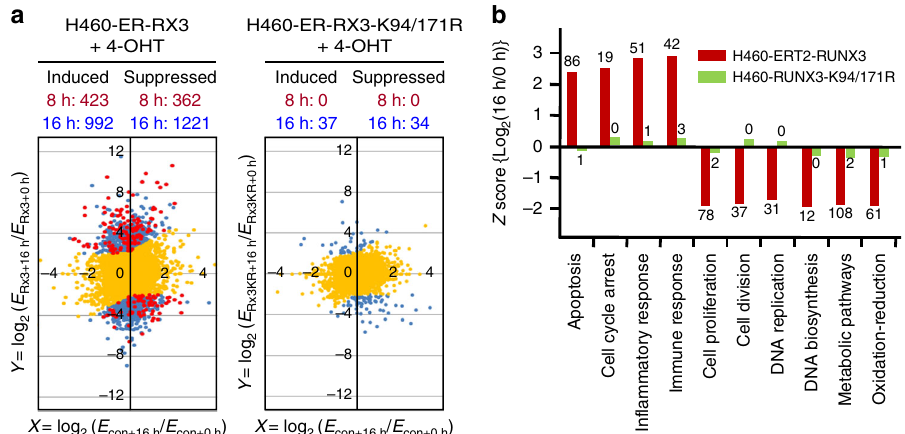
Fig. 10 The R-point governs multiple programs of tumor suppression. a H460-vec, H460-ERT2-RUNX3, and H460-ERT2-RUNX3-K94/171R cells were serum-starved for 24 h, and then stimulated with 10% serum or 10% serum + 1 μ M 4-OHT for 0, 8, or 16 h. RNA was extracted from the cells, and gene expression patterns were analyzed by mRNA sequencing. Expression of genes 8 or 16 h after serum stimulation was quanti fi ed as log 2 (fold change) relative to the average of control reactions (i.e., before serum stimulation, 0 h) for each cell line. Differential gene expression in response to expression of wild-type RUNX3 was analyzed by plotting log 2 ( E Rx3 + 16h / E Rx3 + 0h ) and log 2 ( E vec + 16h / E vec + 0h ); the results are shown on the left. Differential gene expression changes in response to expression of RUNX3-K94/171R were analyzed by plotting log 2 ( E Rx3KR + 16h / E Rx3KR + 0h ) and log 2 ( E vec + 16h / E vec + 0h ); the results are shown on the right. E Rx3 + 16h and E Rx3 + 0h , E Rx3KR + 16h and E Rx3KR + 0h , and E vec – 16h and E vec – 0h are the average expression levels of genes 0 or 16 h after 4-OHT stimulation in H460-ERT2-RUNX3, H460-ERT2-RUNX3-K94/171R, and H460-vec cells, respectively. Yellow spots indicate genes regulated in a RUNX3 -independent manner. Red and blue spots indicate genes regulated in a RUNX3 -dependent manner 8 and 16 h after 4-OHT stimulation, respectively (FDR < 0.001, p < 0.05). b RUNX3-dependent genes involved in various signaling pathways were analyzed using the DAVID Bioinformatics Resources 6.8 37 . Gene expression levels 16 h after 4-OHT stimulation in the indicated cells were quanti fi ed as the fold change relative to the average of un- stimulated levels. Z -scores of log 2 ( E Rx3 + 16h / E Rx3 + 0h ) and log 2 ( E Rx3KR + 16h / E Rx3KR + 0h ) for major signaling pathways are shown for H460-ERT2-RUNX3 and H460-ERT2-RUNX3-K94/171R cells. Numbers at the top or bottom of the bars indicate the numbers of genes signi fi cantly up- or downregulated by inducer treatment. All categories were enriched with p <